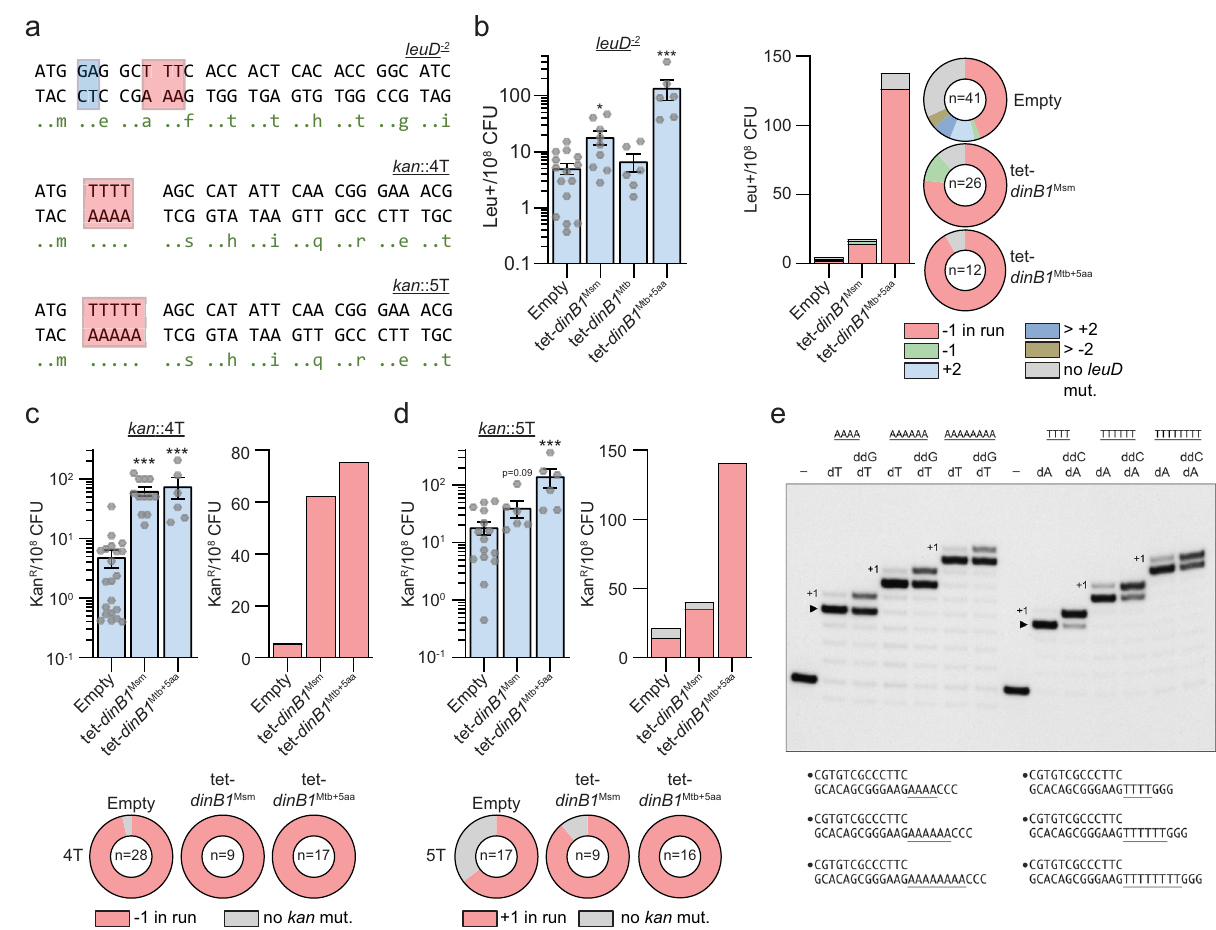
Fig. 5 | DinB1 promotes − 1 and +1 frameshift mutations in homo- oligonucleotideruns.a leuD and kan frameshift(FS)reporterassays. leuD and kan open reading frame N-termini in which 2 base pairsin the second leuD codonwere removed (blue box) or 4T/5T runs (red box) were incorporated upstream the start codon of kan . Reversion can occur by FS mutations that restore the leuD or kan reading frames resulting in phenotypic leucine prototrophy (leu + ) or kanamycin resistance (kan R ).The red box in leuD shows the run of 3T in which the majority of detected FS in leu + were found. b leu + and c , d kan R frequencies in the indicated strains in presence of inducer. Results shown are means (±SEM) of data obtained from biological replicates symbolized by gray dots. Stars above the means mark a statistical difference with the reference strain (empty) (*, P <0.05; ***, P <0.001). p-values were obtained on log-transformed data by one-way ANOVA with a